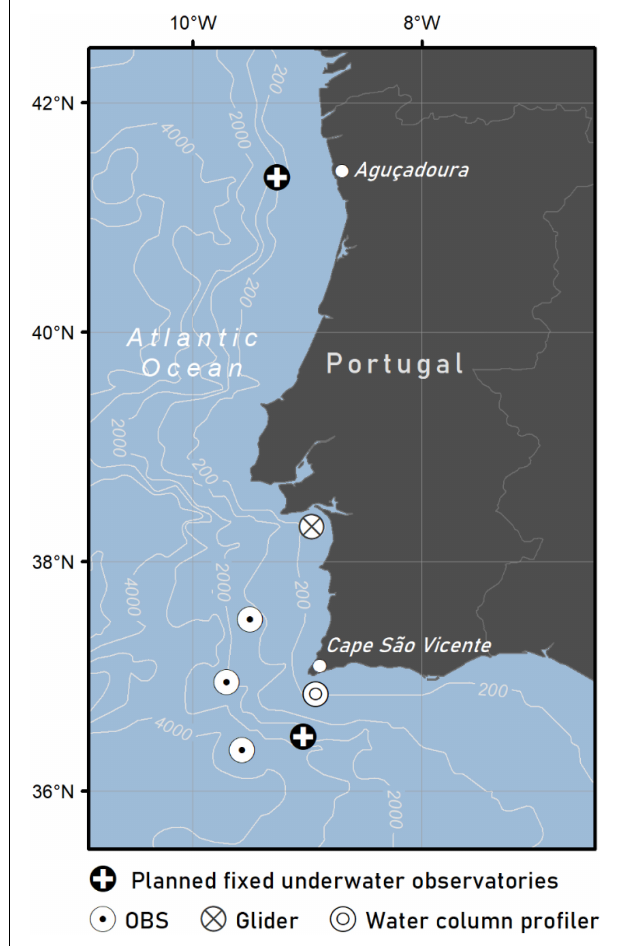
FIGURE 1 | Planned location of the two fixed underwater observatories. Location of deployment of the water column profiler, ocean-bottom seismometers (OBSs), and test area of the glider in the scope of the EMSO-PT pilot oceanographic